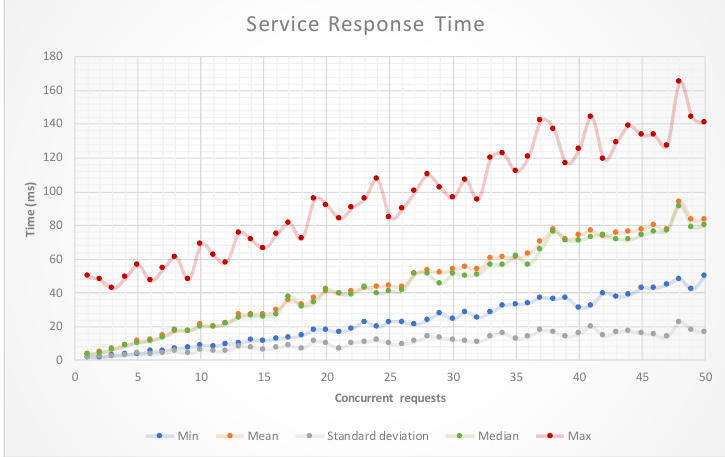
Figure 9. Evolution of the UV index.